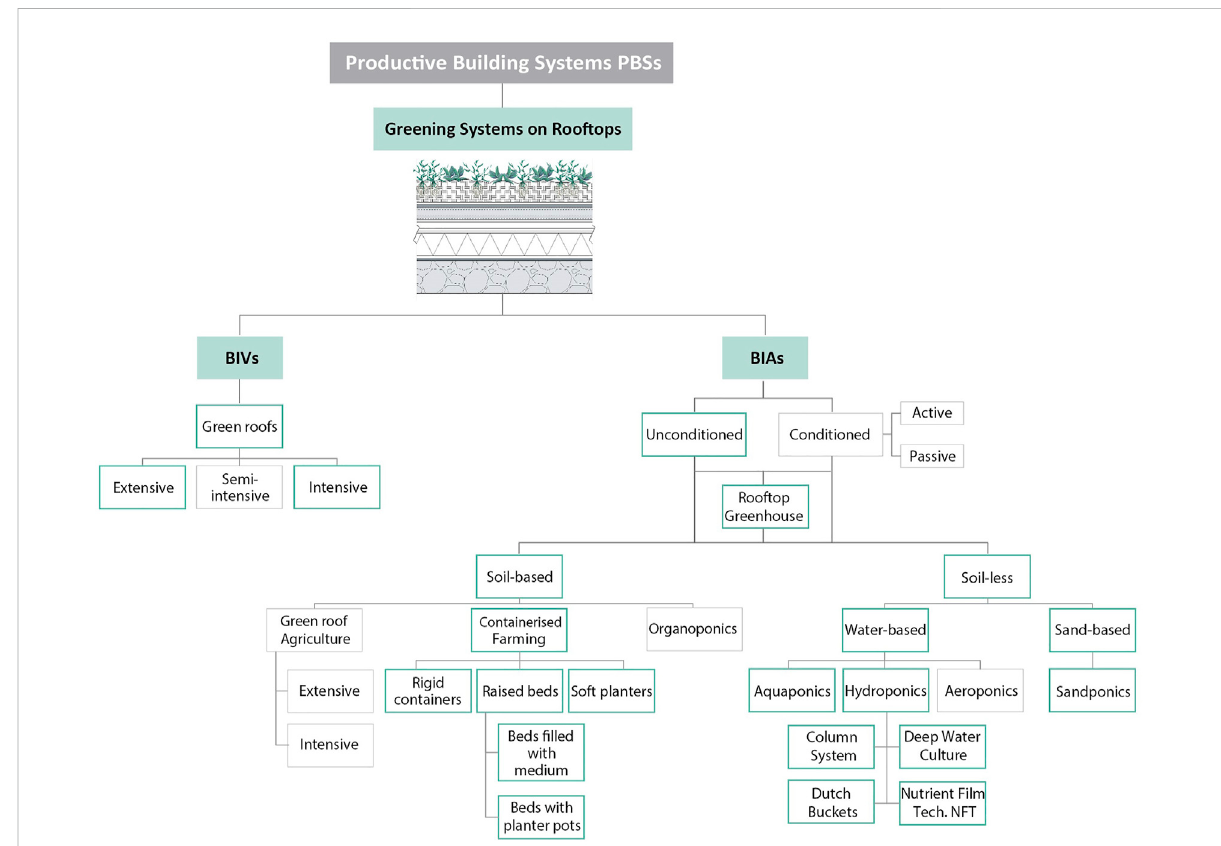
FIGURE 3 Inventory of greening systems (BIVs and BIAs) on rooftops, compiling the types and classi fi cations identi fi ed from assessed studies and reports to create the body of classi fi cation (all boxes). Structured based on (Savvas 2013; Raji et al., 2015; Caputo et al., 2017; Rodríguez-Delfín et al., 2017; Benis et al., 2018; Ledesma et al., 2020) with additions. Systems existing in the Egyptian market are highlighted by the green-bordered boxes. PBSs: Productive Building Systems, BIVs, Building-Integrated Vegetation systems; BIAs, Building-Integrated Agriculture Systems; DWC, Deep Water Culture; NFT, Nutrient Film